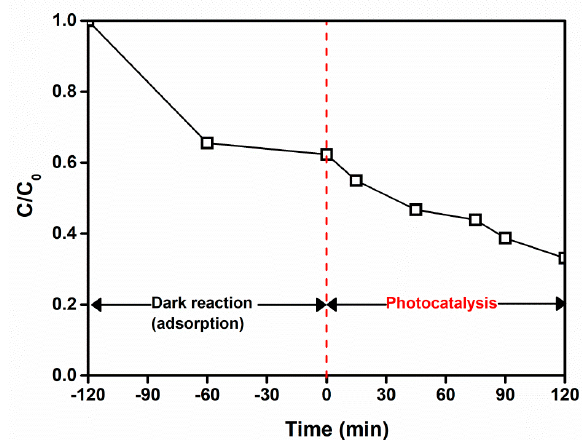
Figure 3. Solar visible light-driven photocatalysis of methylene blue (MB) with MS-TiO 2 . Experimental conditions: [MB] o = 20 mg/L, I = 60 mW/cm 2 , pH = 6, [TiO 2 ] = 0.75 g/L